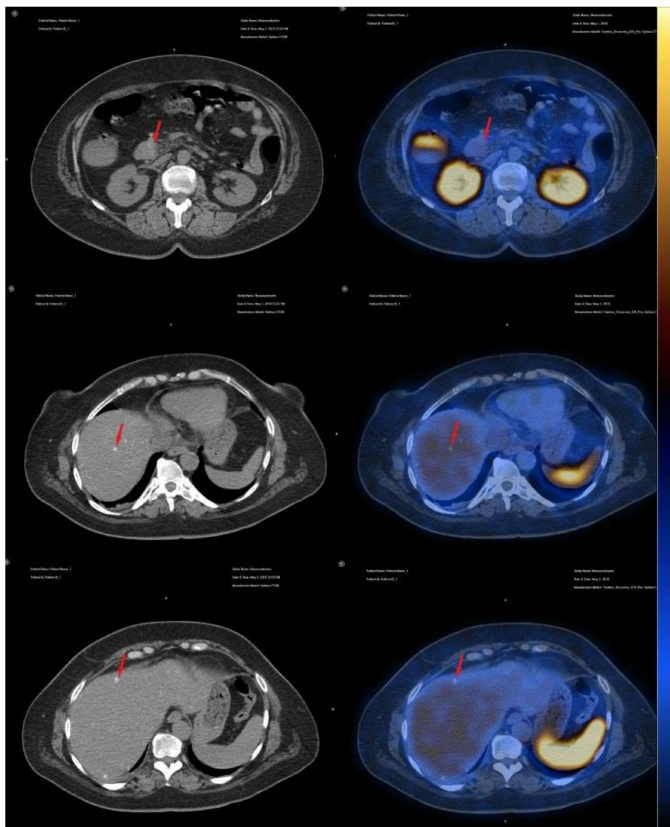
Figure 10. Axial unenhanced CT and fused SPECT-CT images showing duodenal tumor and multiple small hepatic metastasis with no uptake of 99mTc-EDDA / HYNIC-Tyr3-Octreotide (red arrows).